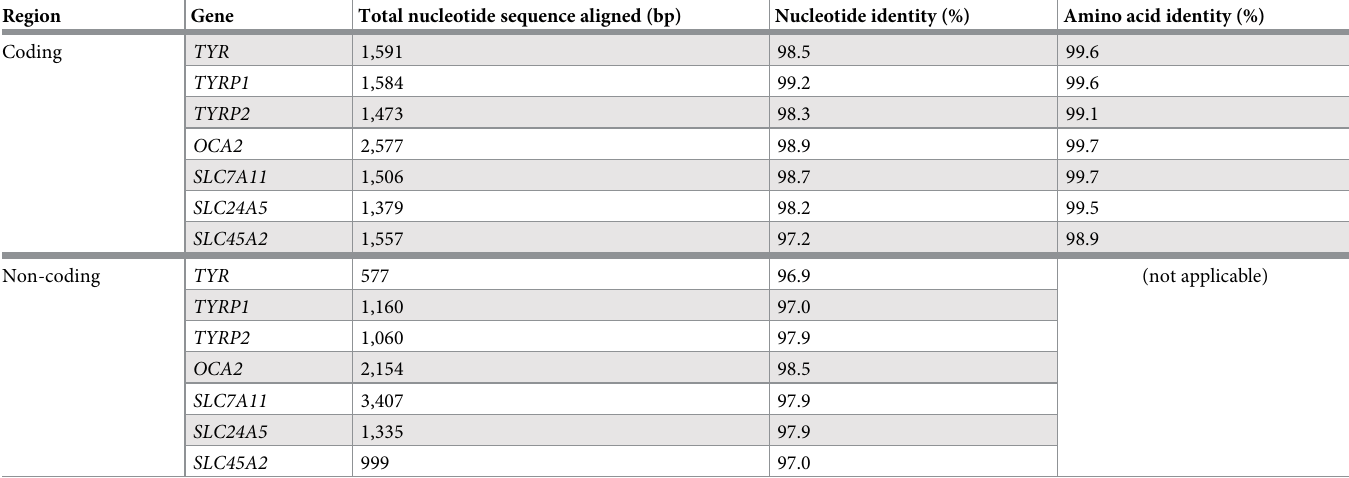
Table 2. Comparison of ball python and Burmese python genomic and protein sequences for melanogenesis genes.